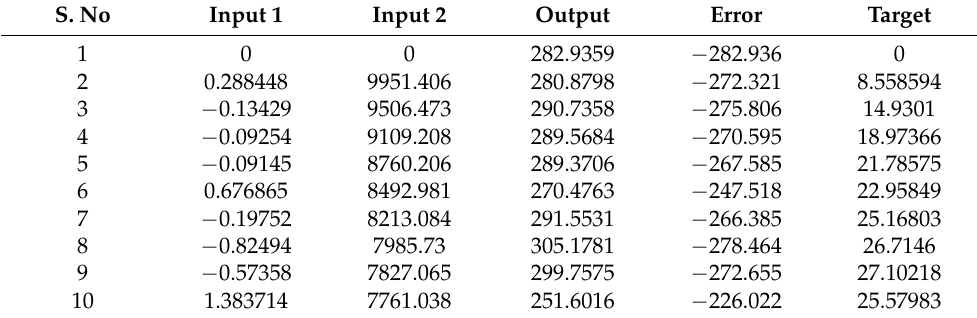
Table 4. Sample Data for an ANN.